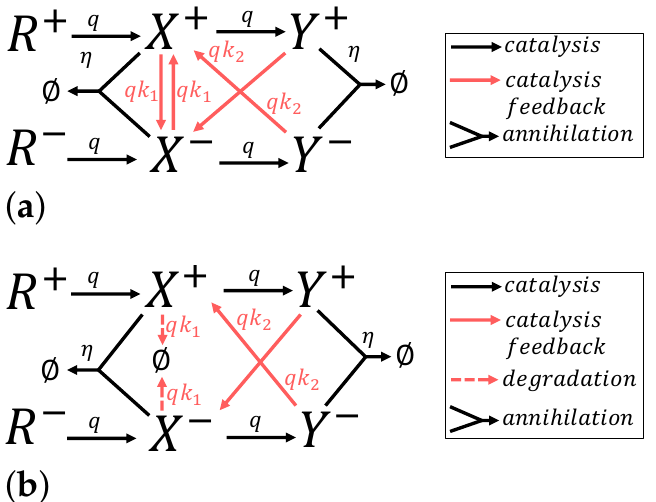
Figure 13. Network of chemical reactions for dual-rail representation of the state feedback control system, using ( a ) catalytic degradation or ( b ) degradation